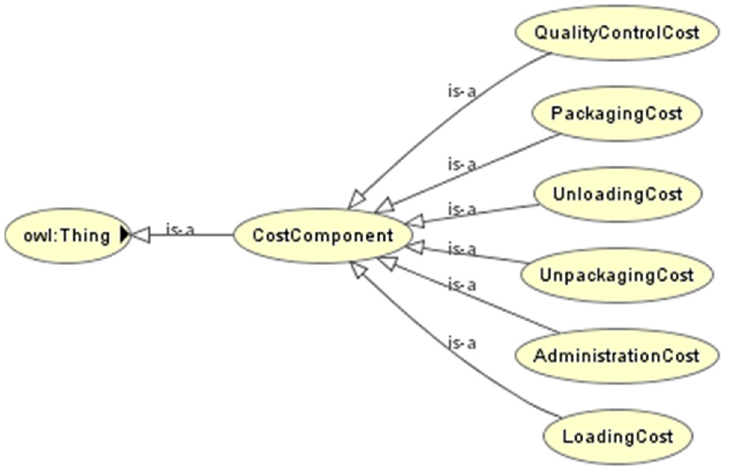
Figure 9. The CostComponent class.